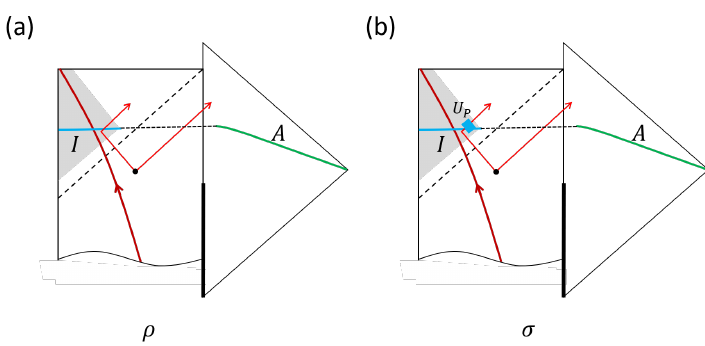
Figure 2 . Illustration of two states ρ, σ which are only different by a local unitary U P acting on a small region P in the island. For example U P can flip the spin of a particle. The QFT states are defined on a Cauchy surface that includes A and I